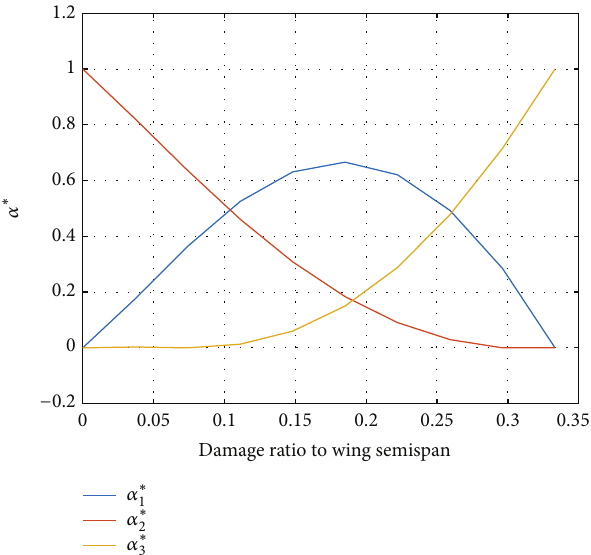
Figure 1: The curves of the interpolation coefficients to wing tip loss ratios.